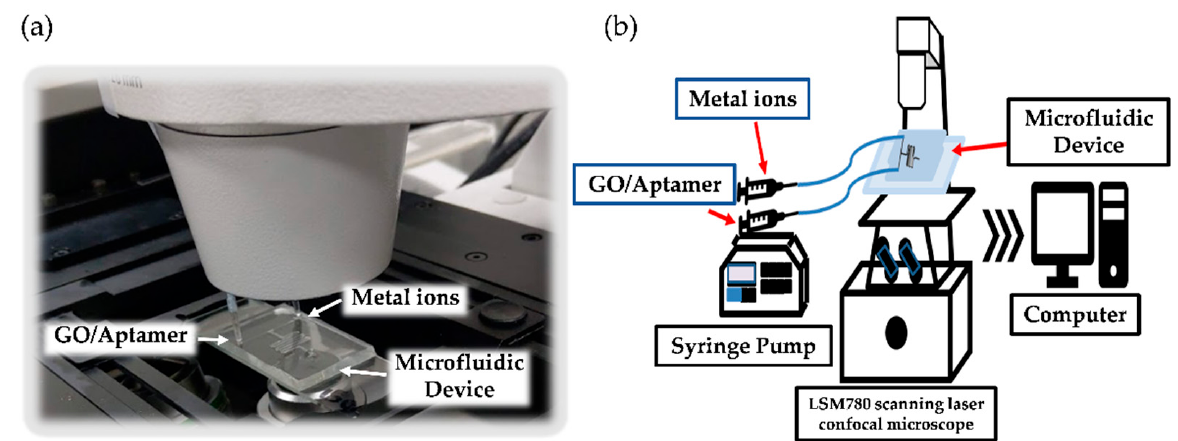
Figure 2. ( a ) Experimental setup used for Hg 2+ and Pb 2+ ion detection. ( b ) Schematic integration of the measurement system.